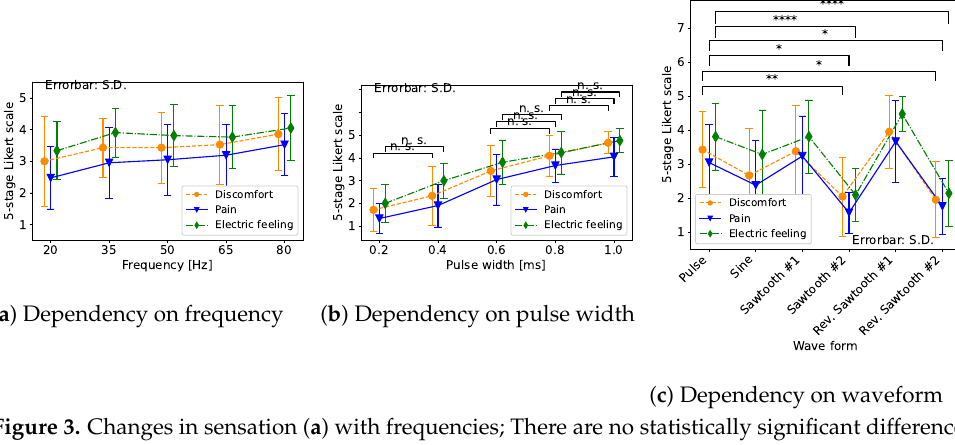
Figure 3. Changes in sensation ( a ) with frequencies; There are no statistically significant differences ( b ) with pulse width; we confirmed statistically significant differences except for the n. s. pair ( c ) with waveforms; this figure shows only combinations that are significantly different from pulse waves. *, ** and **** represent significance levels of 5%, 0.5%, and 0.005%. In Figure 3a–c, the orange lines show the answer of “discomfort”, the blue lines show “pain”, and the green lines show “electric feeling”. The vertical axes are the evaluation results on a 5-stage Likert scale. The maximum value is 5 and the minimum value is 1, and the larger the value, the greater the sensation. Each horizontal axis represents the frequen- cies, pulse widths, and waveforms of the input stimuli. Pairwise comparisons between each condition after one-way repeated measures ANOVA were made using Scheffe’s